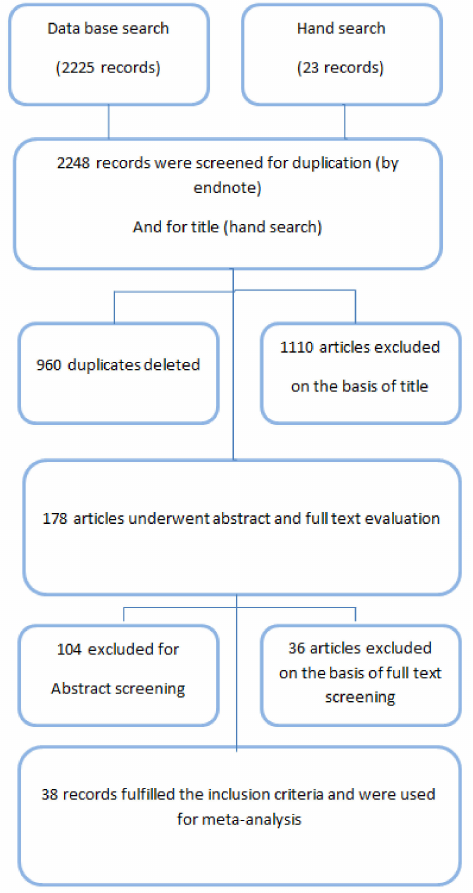
Figure 1. Flow sheet diagram of the selection of the